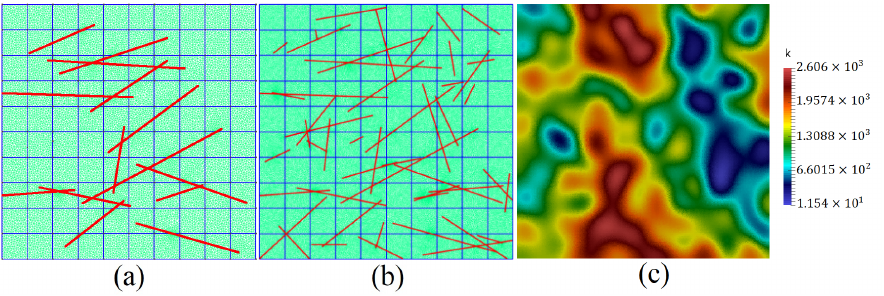
Figure 4. ( a ): computational domain for Test 1 and Test 2 . ( b ): computational domain for Test 3 . Coarse grid (blue color), fine grid (green color) and fracture geometry (red color). ( c ): Heterogeneous coefficient k m , s for Test 2 and Test 3